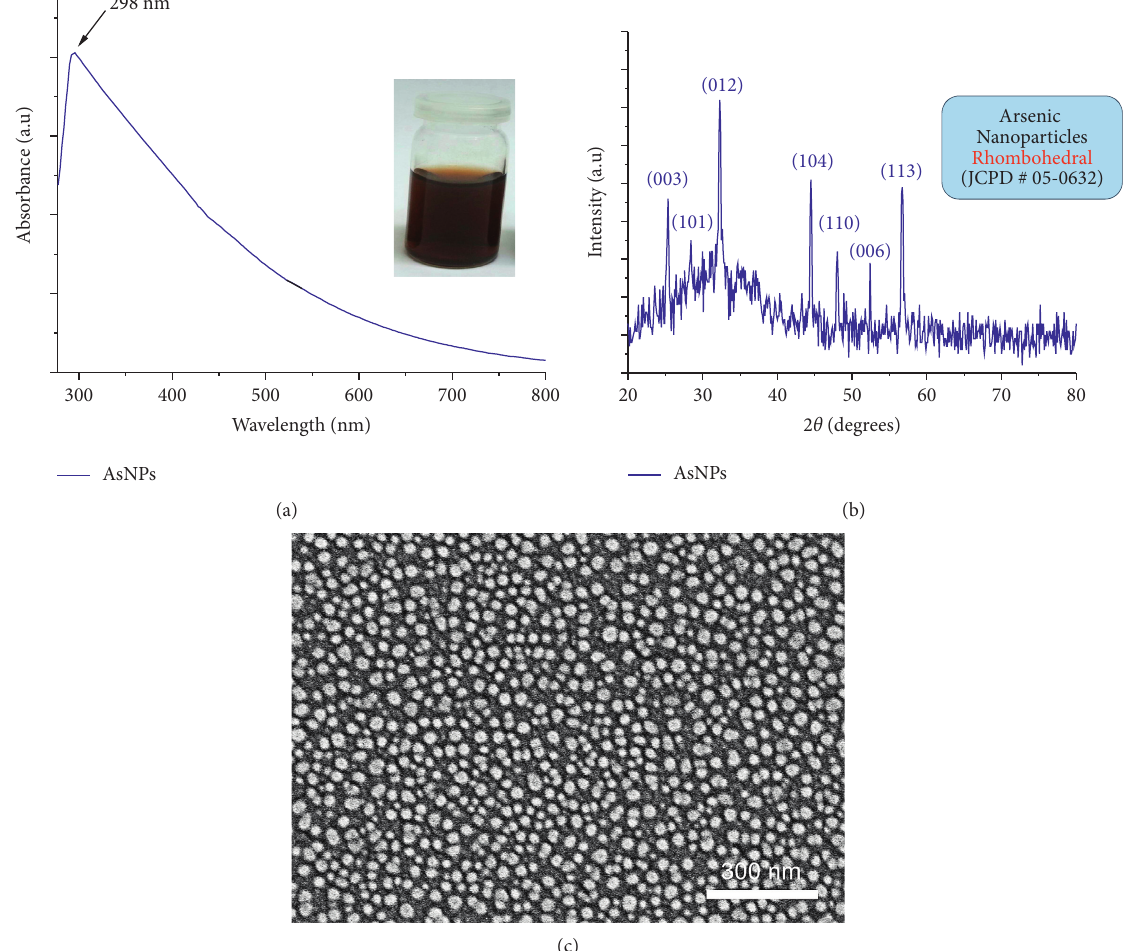
Figure 2: (a) Ultraviolet-visible (UV-Vis) absorption spectra of AsNPs show maximum absorption at around 300nm. (b) XRD pattern of AsNPs indicating rhombohedral crystalline nature. (c) SEM image of showing spherical morphology of AsNPs. Table 2: A. Behavioral manifestation of fish. ++: good activity, +: slightly low activity, + − : very low activity, − : loss of